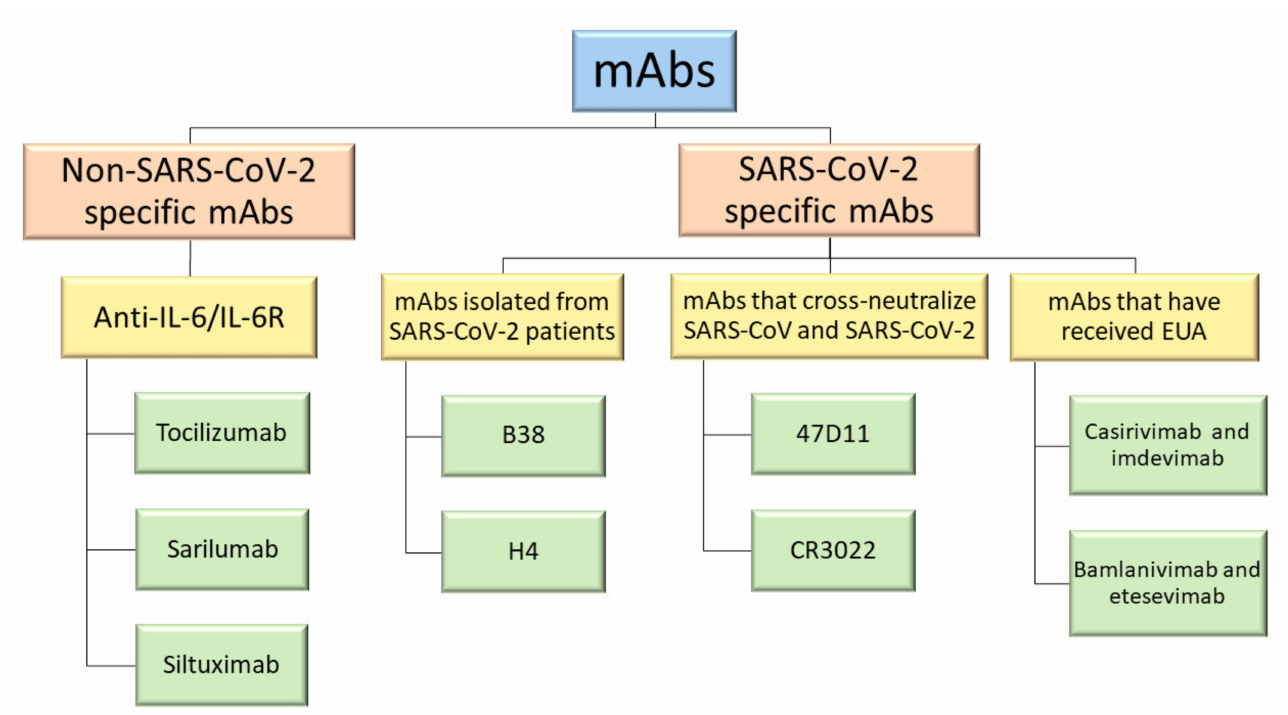
Figure 2. Relevant mAbs used to treat COVID-19 deeper discussed in this